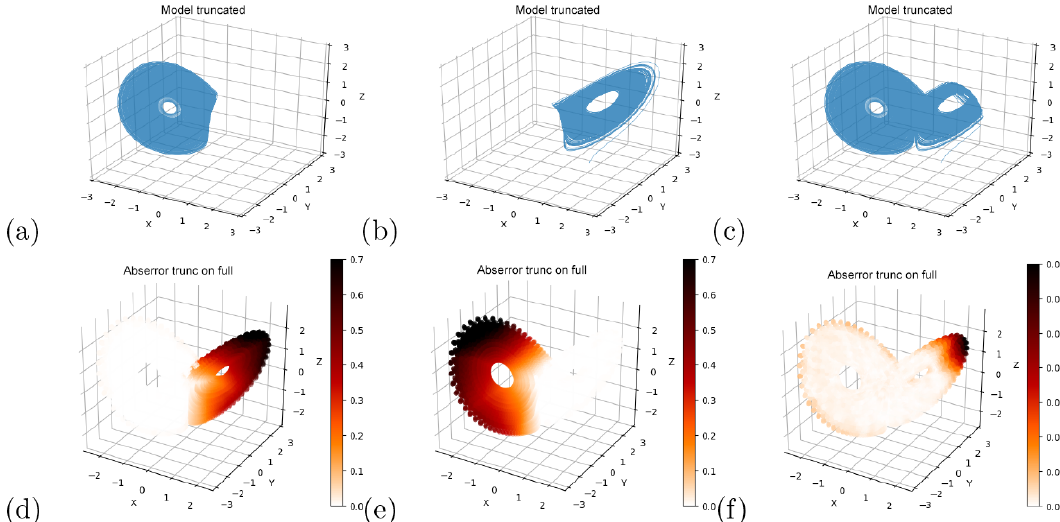
Figure 2. Truncated sets of Lorenz63 training data (a–c) and short-term forecast error (MAE) of neural networks trained on these sets (d–f) . Note the different color scales in (d–f)